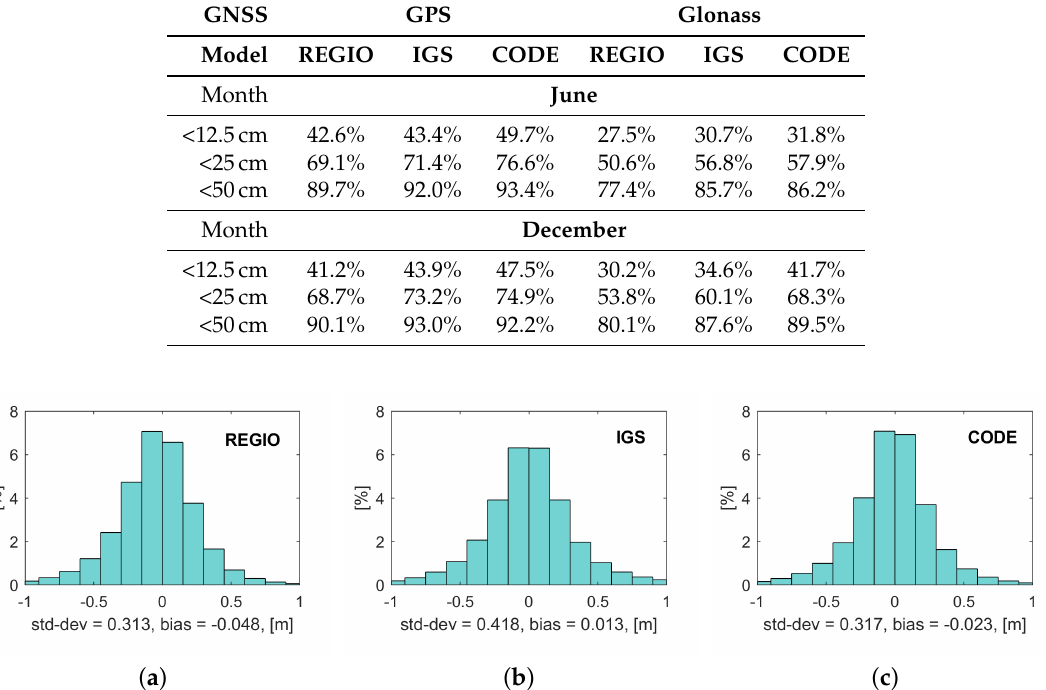
Figure 8. Histogram of the difference between the estimated and modeled ionospheric delay of GPS and Galileo for: ( a ) Regiomontan; ( b ) IGS; and ( c ) CODE for June and December